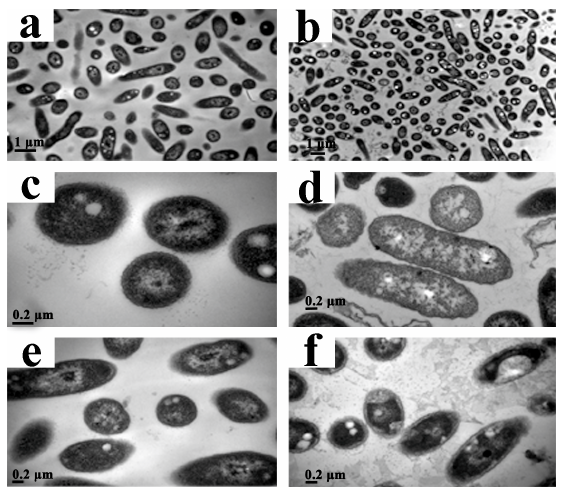
Figure 6. Transmission electron microscopic observation of Acidovorax avenae subsp. avenae strain RS-2 treated without ( a , c , e ) and with 0.5 mg/mL of CPT ( b , d , f ). Scale bar in ( a , b ) = 1.0 μ m; in ( c – f ) = 0.2 μ m.